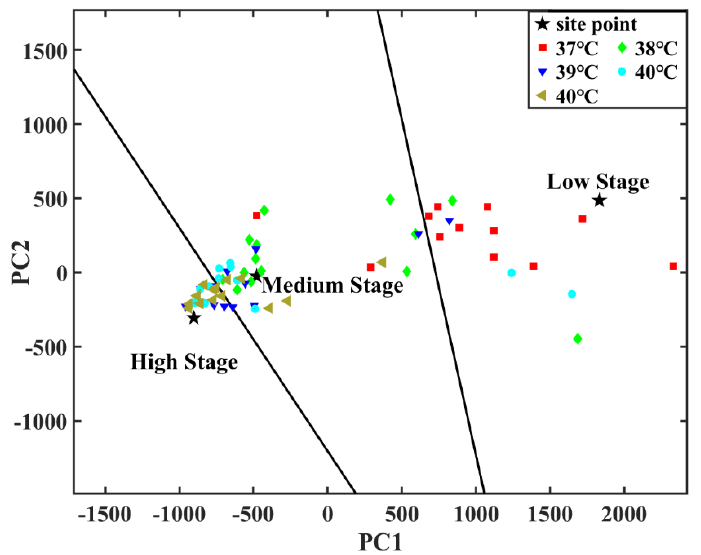
Figure 7. A distribution sample of the two main PCA components in the HRV of the BT at the five water temperatures on a Voronoi diagram generated by low, medium, and high stages (subject V).